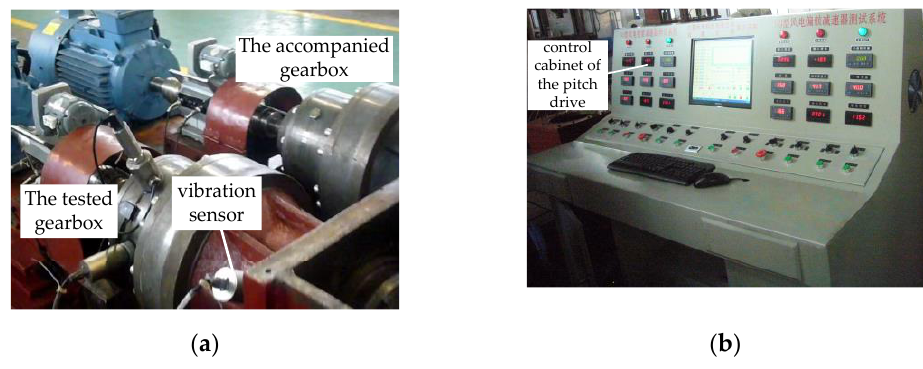
Figure 14. The test rig of the pitch drive. ( a ) Test rig; ( b ) control cabinet. 4.2. Experimental Results Since the carrier in the third stage is connected to the output shaft, their displace- ments are similar. Thus, the displacement of the carrier in the third stage is replaced by that of the output shaft. The vibration displacements of the carrier in the third stage under